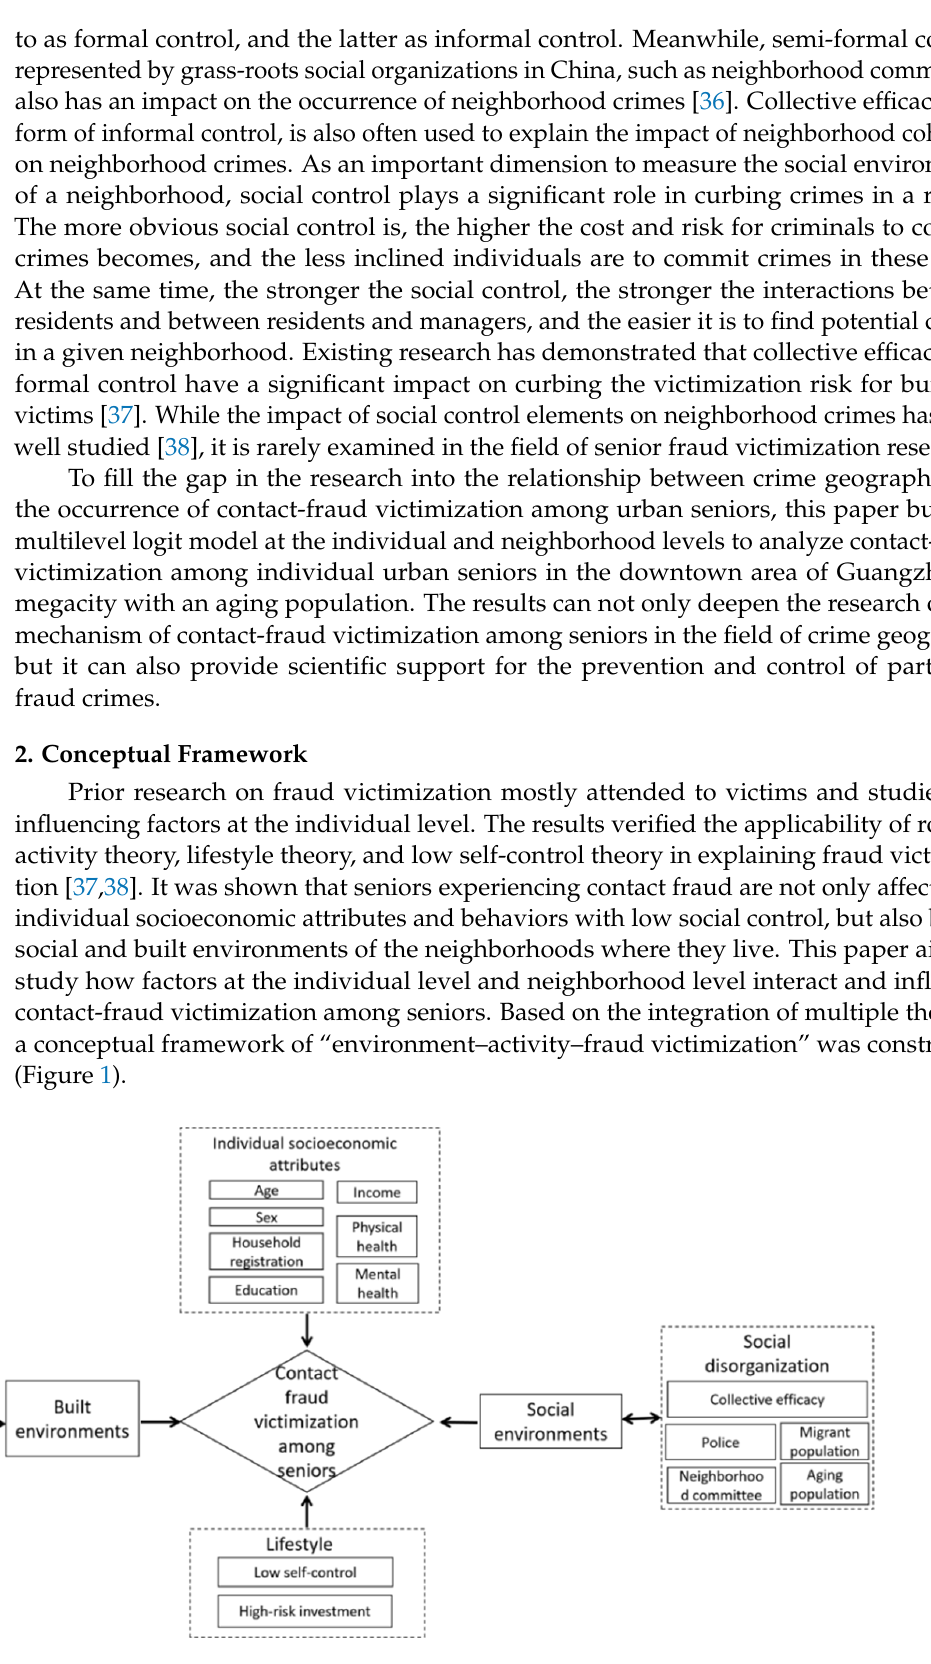
Figure 1. The conceptual framework.